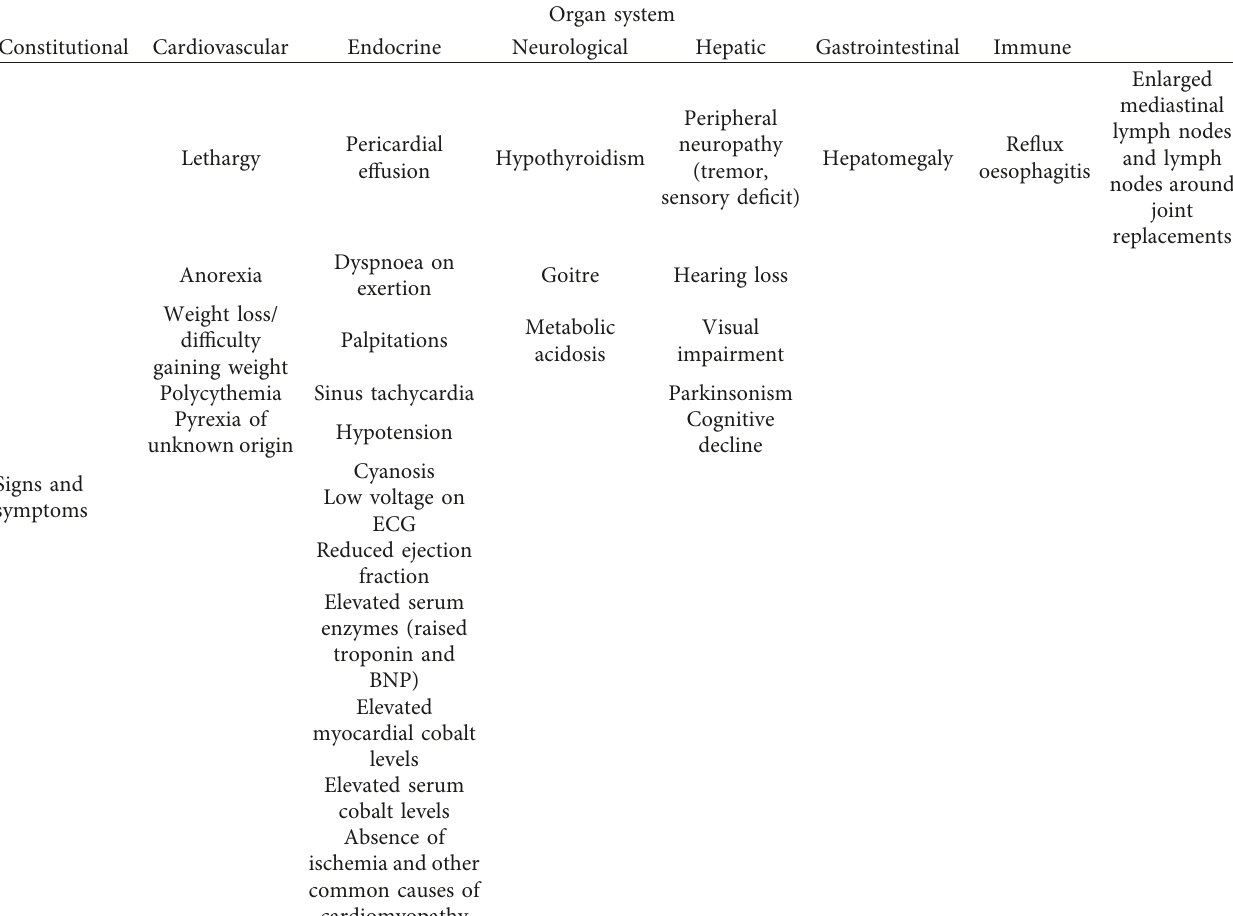
Table 1: Signs and symptoms of cobalt toxicity by organ